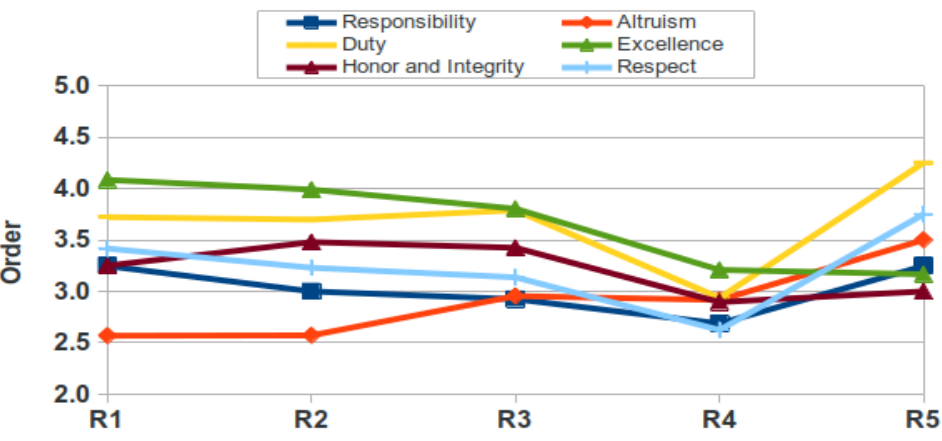
Figure 7. Order of importance of categories for female residents (R, resident).